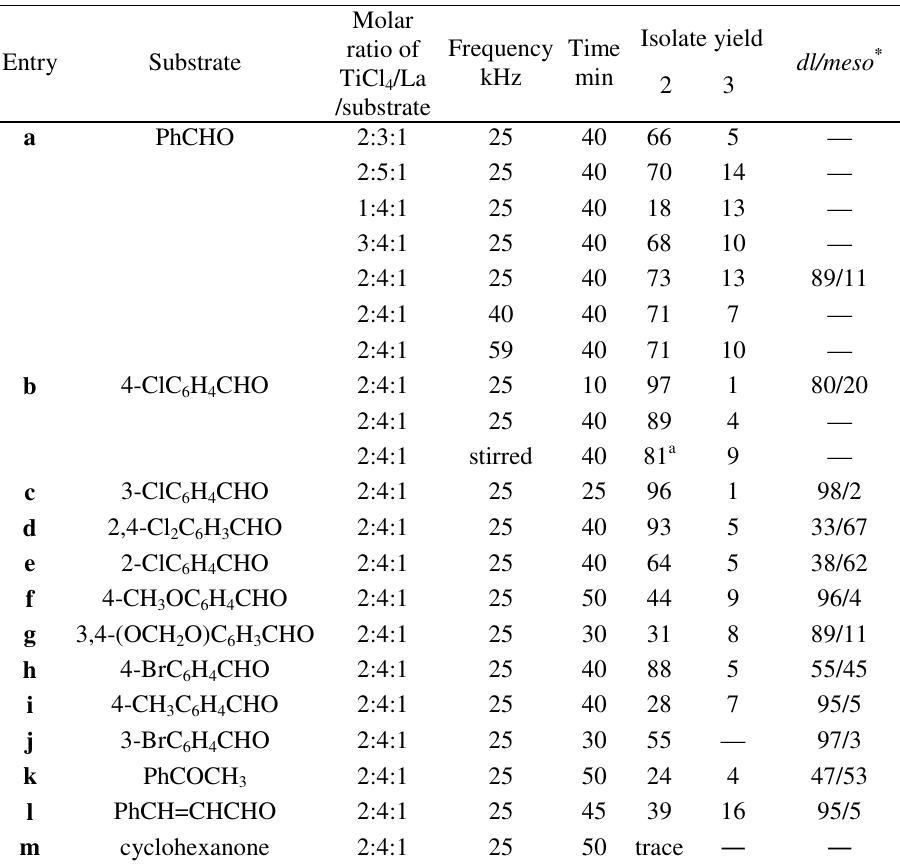
under ultrasound